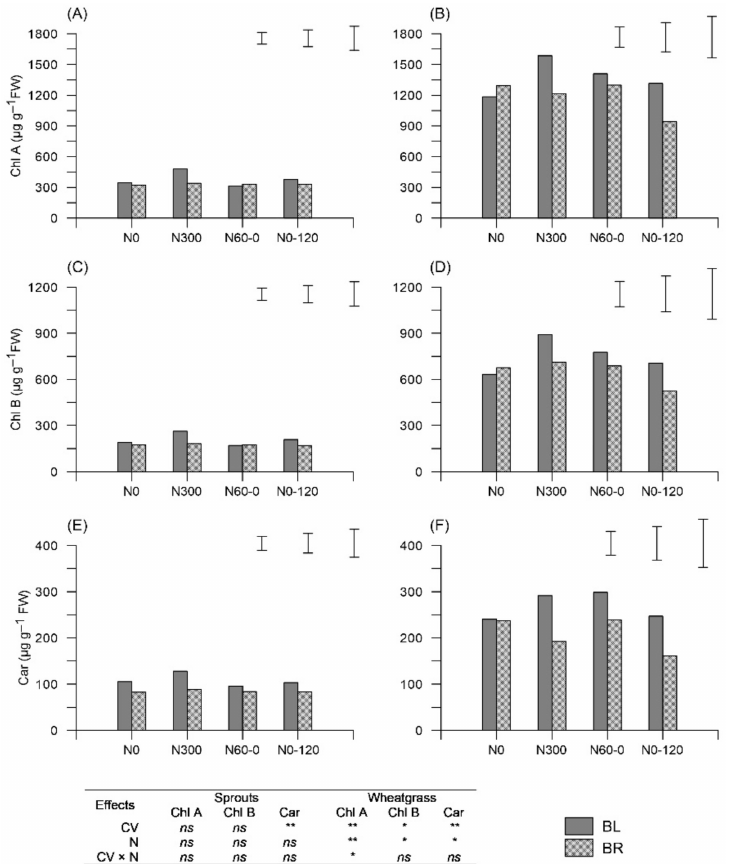
Figure 1. Chlorophyll A (Chl A), Chlorophyll B (Chl B), and carotenoid (Car) concentration ( µ g g − 1 fresh weight, FW) as determined in sprouts ( A , C , E for Chl A, Chl B, and Car, respec- tively) and wheatgrass ( B , D , F for Chl A, Chl B, and Car, respectively) obtained from seeds of two Triticum aestivum cultivars (Bologna, BL; Bora, BR) subjected to four different N fertilization schedules (N0: unfertilized control; N300: constantly well N fertilized throughout the growth cycle; N60-0: N fertilized only one month after sowing; N0-120: N fertilized only late at initial shoot elonga- tion). In the box, the F-test from the analysis of variance (ANOVA): two-factor ANOVA at 5% level of probability; cultivar (CV); N fertilization schedules (N). * p < 0.05; ** p < 0.01; ns = not significant. Bars represent the Least Significant Difference (LSD; p < 0.05) for CV, N, and CV × N (from left to